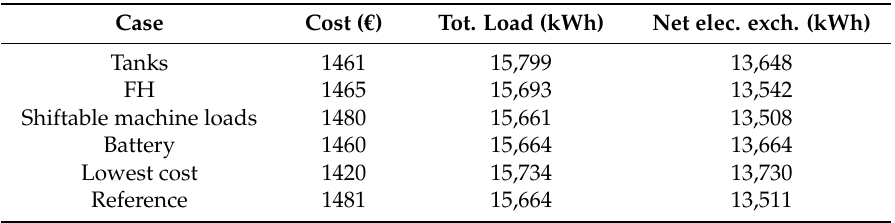
Table 8. The results of the simulations with single flexibility